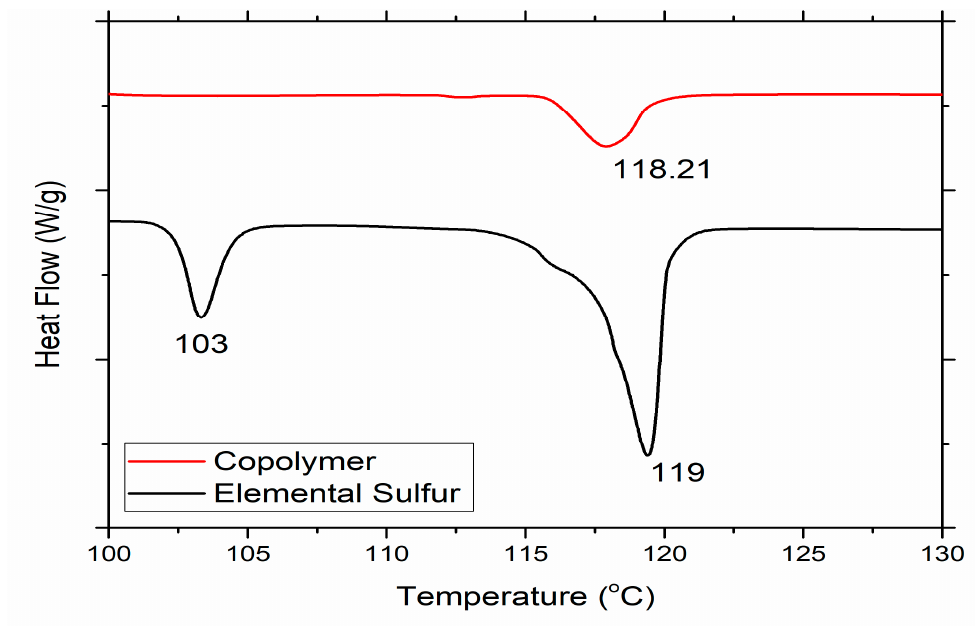
Figure 6. DSC thermogram of the optimized copolymer.